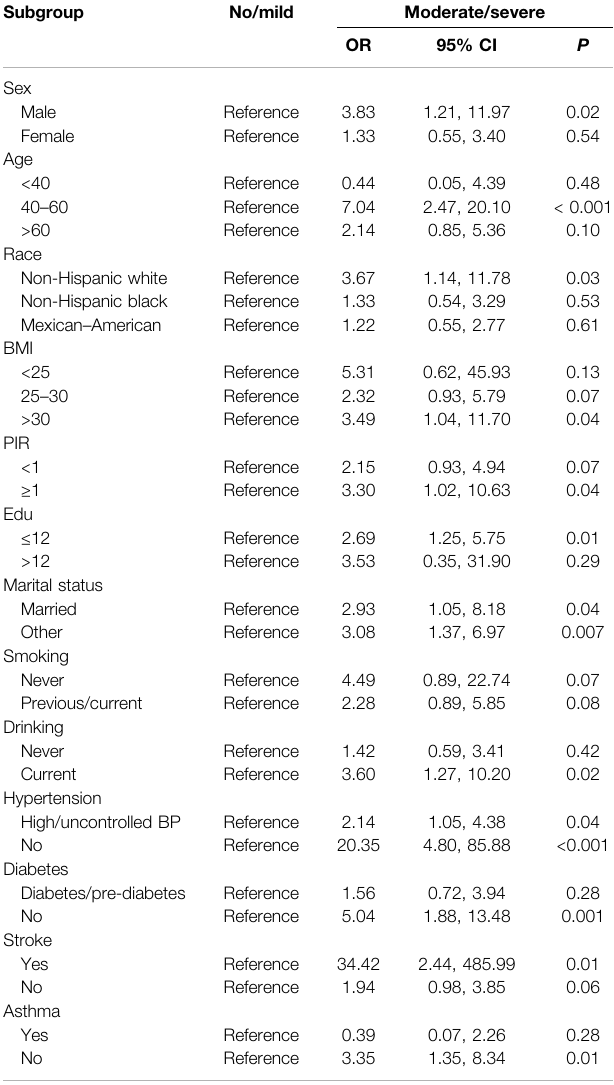
TABLE 4 | Subgroup